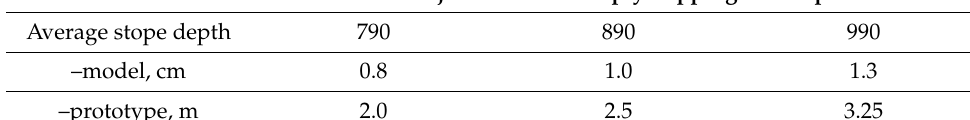
Table 2. Results of the research on model and prototype deformations in hanging wall.